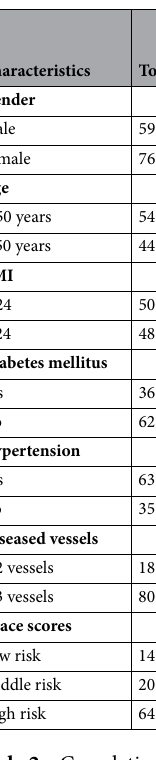
Table 2. Correlations between the serum LncRNA PELATON with clinical